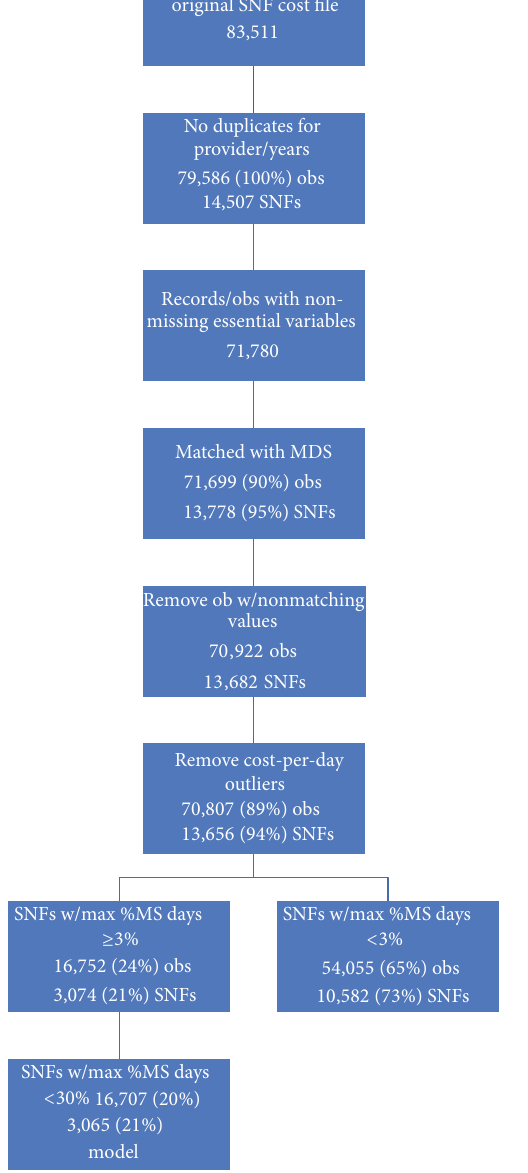
Figure 1: Medicare cost reports: flowchart. The hybrid cost function was estimated on a subset of SNFs including about 20% of facilities with more than 3% of annual residents-days attributed to patients with MS. The dependent variable was defined as logarithmic trans- formation of skilled nursing facility inpatient costs . The independent variables included facility percent of MS days, county-year mean of facility average wage, number of inpatient days and admissions, facility for-profit and ownership status, area competition index, and interactions between them. MS = multiple sclerosis; SNF = skilled nursing facility.